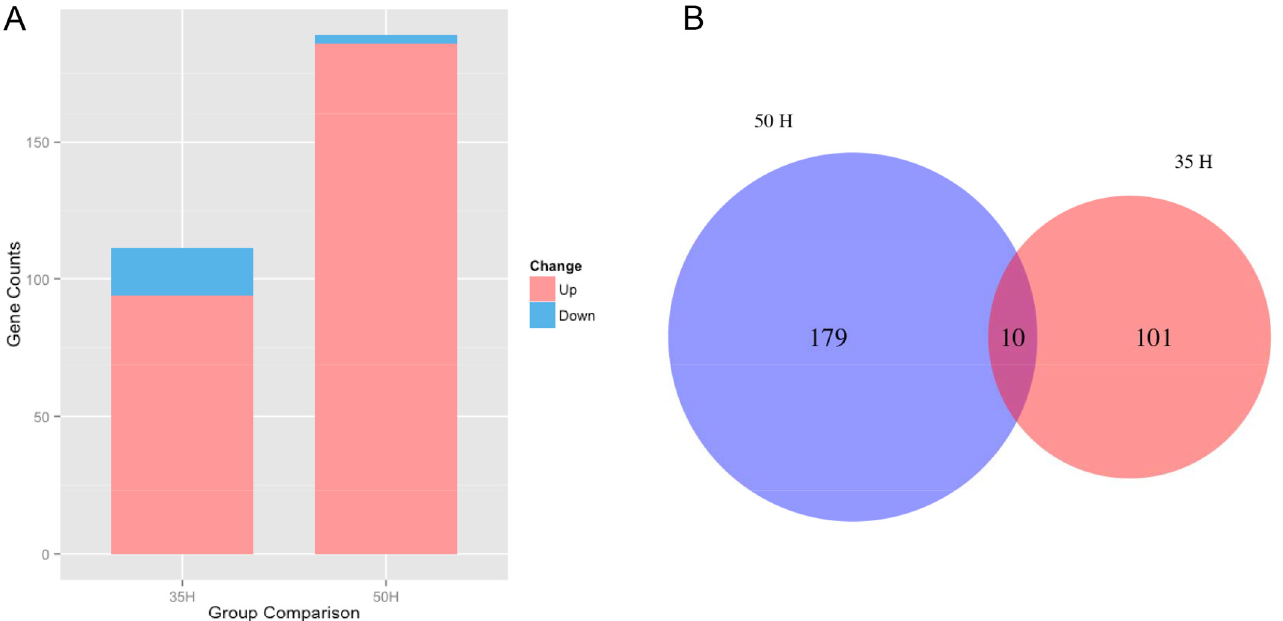
Fig 3. (A) Gene expression changes in two comparisons; (B) Venn diagram of differential genes in two comparisons. The significance levels ( P- value) were analyzed between RF exposure and sham control groups. There were 94 upregulated and 17 downregulated genes at 35h and 186 upregulated and 3 downregulated genes at 50h. There were ten genes that were differentially expressed in both time points. The thresholds of false discovery rate (FDR) < 0.01 and absolute log fold change > 2 were used to determine the significantly upregulated and downregulated genes between different